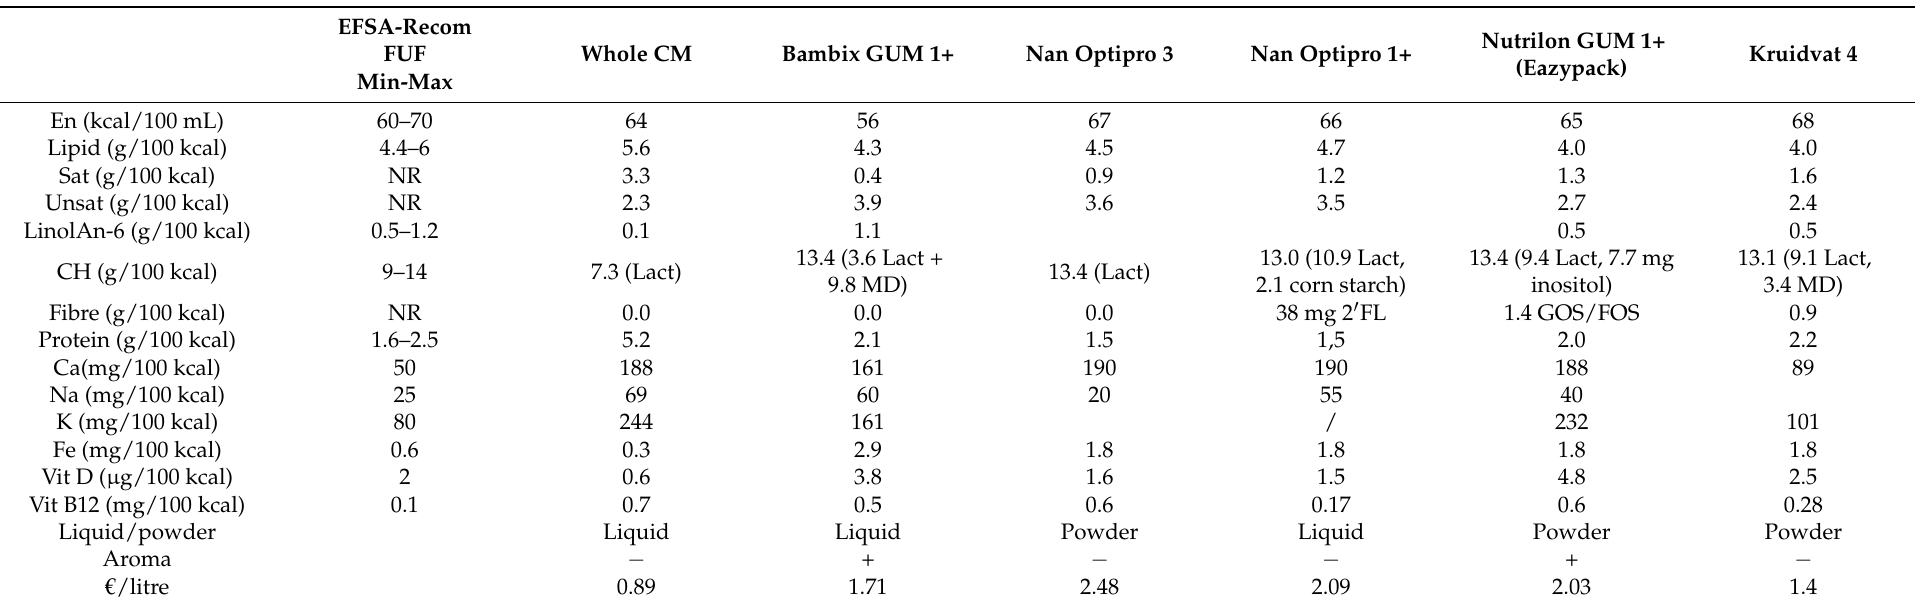
Table 1. Composition of some cow’s milk based growing up milk or young child